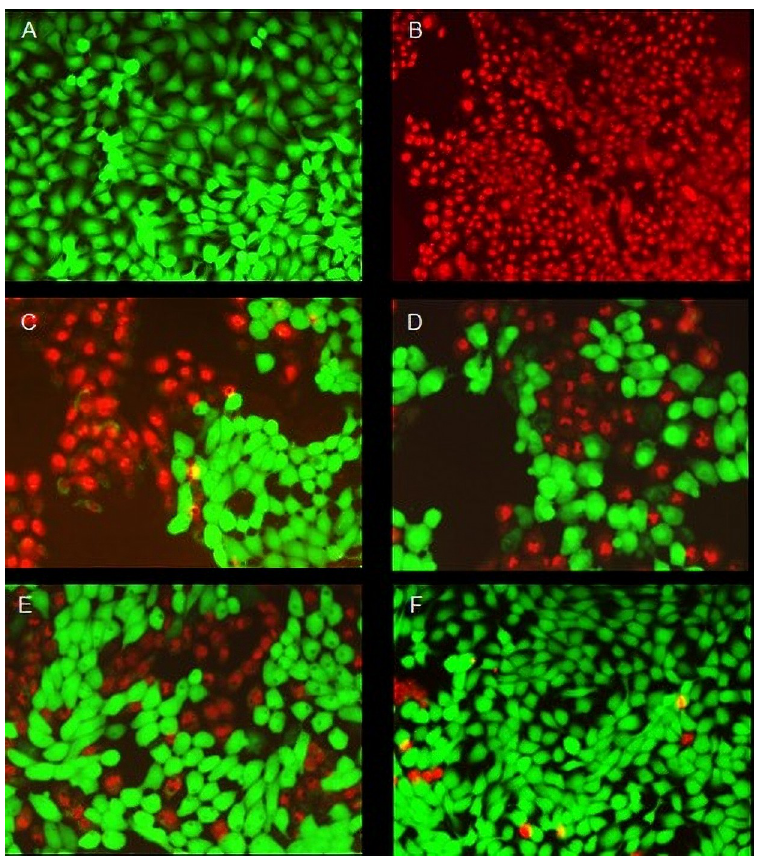
Fig 2. Fluorescence images showing the viability of the HaCaT cells treated with articaine formulations at the IC 50 concentration for 1 h at 37˚C. (A) live cells (negative control); (B) dead cells (positive control treated with 70% methanol); treatments with (C) ATC; (D) ATC epi ; (E) ATC nano ; (F) ATC nanoepi . Each image is composed of two superimposed images taken through different filters for green (calcein) and red (homodimer-1) fluorescence. All images were acquired at the same magnification